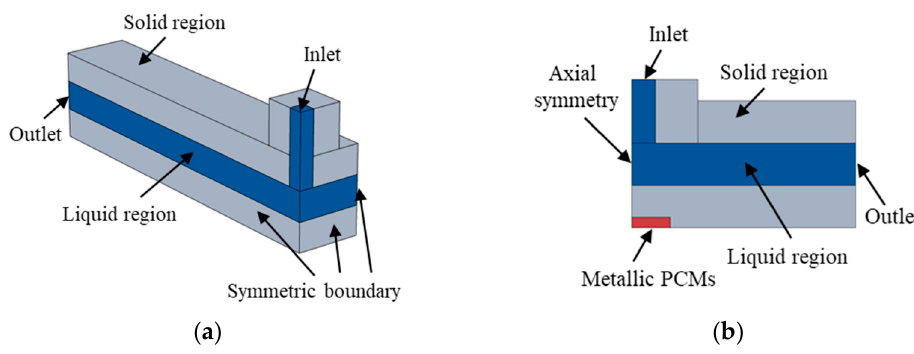
Figure 1. Numerical calculation geometry models: ( a ) 3D; ( b ) 2D axisymmetric .